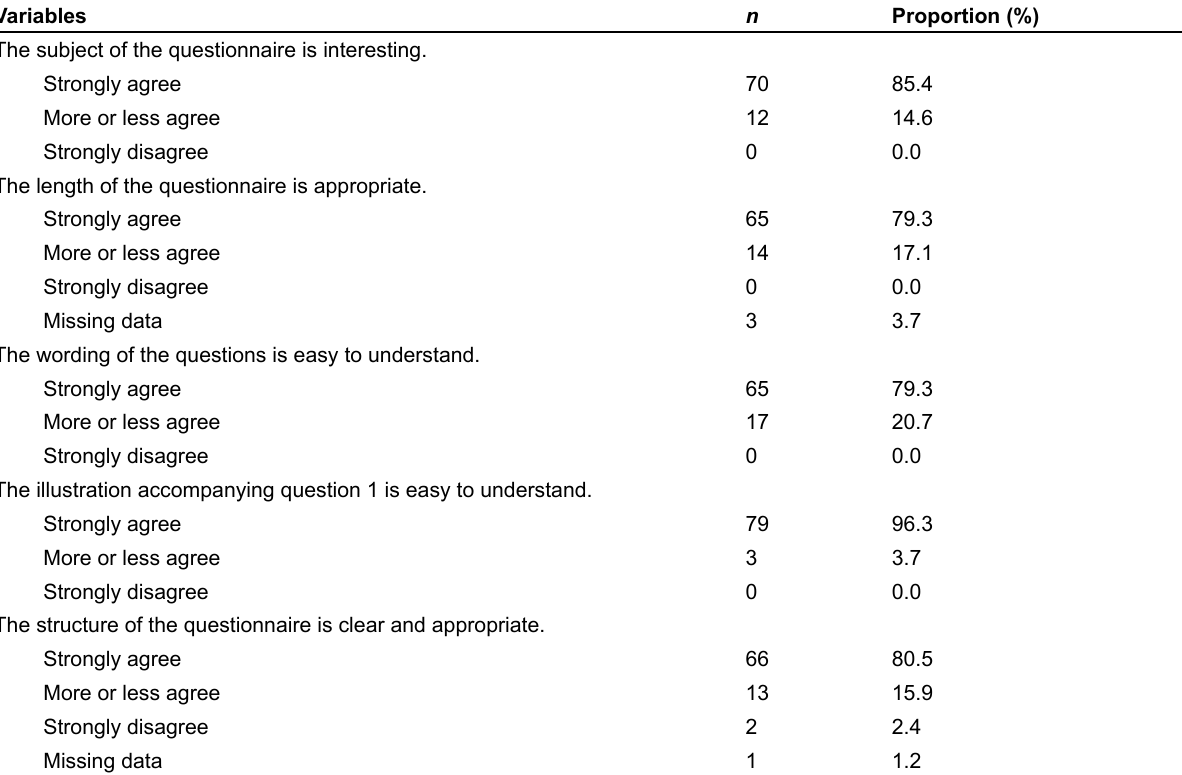
Table 4. Evaluation of the Delphi DOLBaPP questionnaire by the participants ( continued ) Variables n Proportion (%) The subject of the questionnaire is interesting.